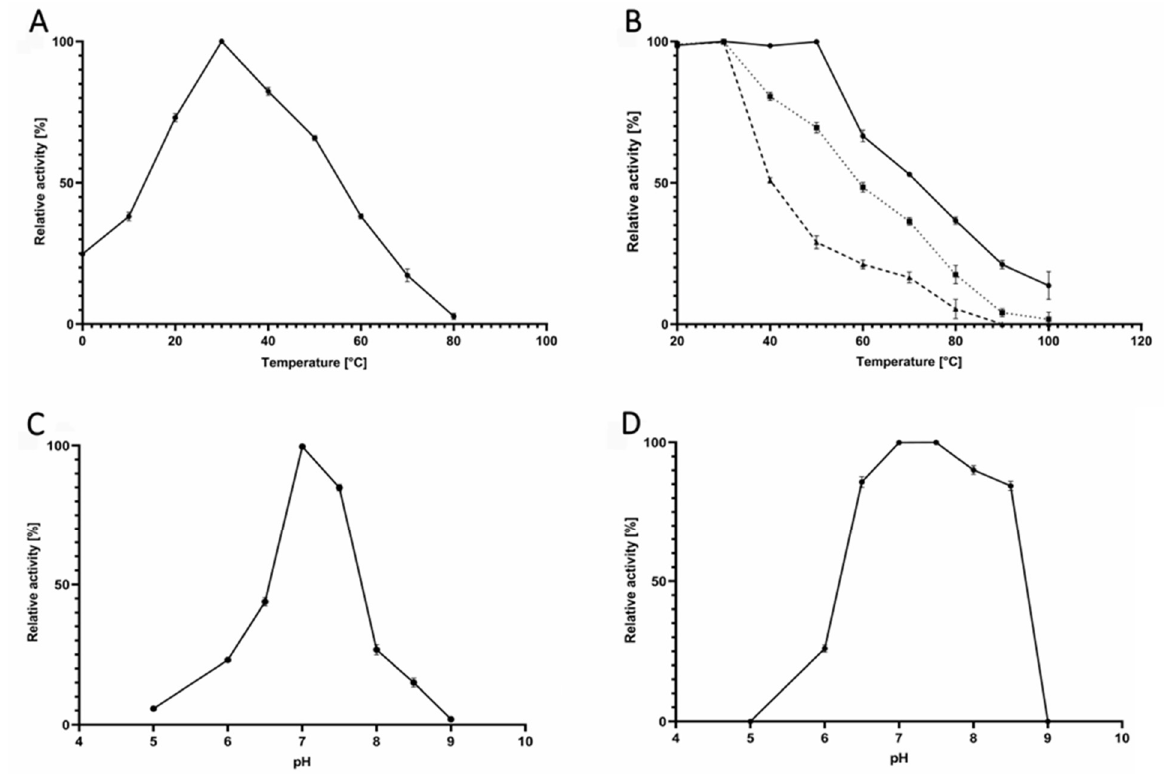
Figure 5. Temperature and pH profiles of MAO P3. The n -butylamine at a concentration of 20 mM was used as a substrate. ( A ) The temperature profile of MAO P3. The activity of the enzyme was assayed at different temperatures. ( B ) Temperature stability of MAO P3. The activity was measured after incubation of the enzyme at various temperatures after different times of incubation: 30 min (full line), 45 min (dotted line), 60 min (dashed line). ( C ) pH profile of MAO P3. The activity of the enzyme was assayed in the pH range of 5.0–9.0 for 30 min at 30 ◦ C. ( D ) pH stability. The activity was measured after incubation for 1 h at 10 °C in the pH range 5.0–9.0.